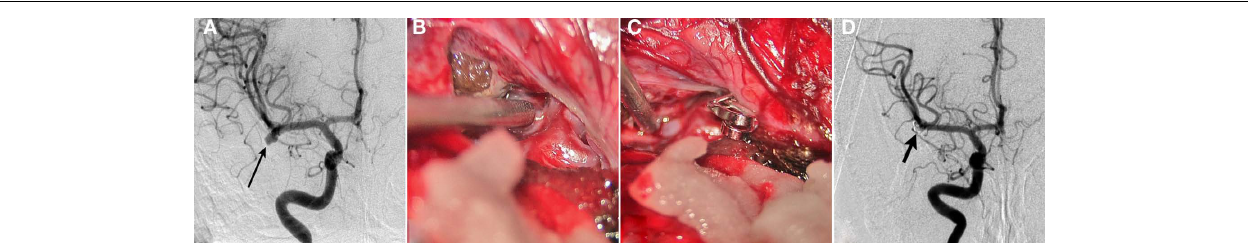
FIGURE 1 | Clipping of MCA aneurysm. A 49-year-old woman presented with subarachnoid hemorrhage. (A) Cerebral angiography demonstrated a 6-mm right MCA bifurcation aneurysm. Like most MCA aneurysms, this lesion had a wide neck involving the origins of the insular (M2) MCA divisions.